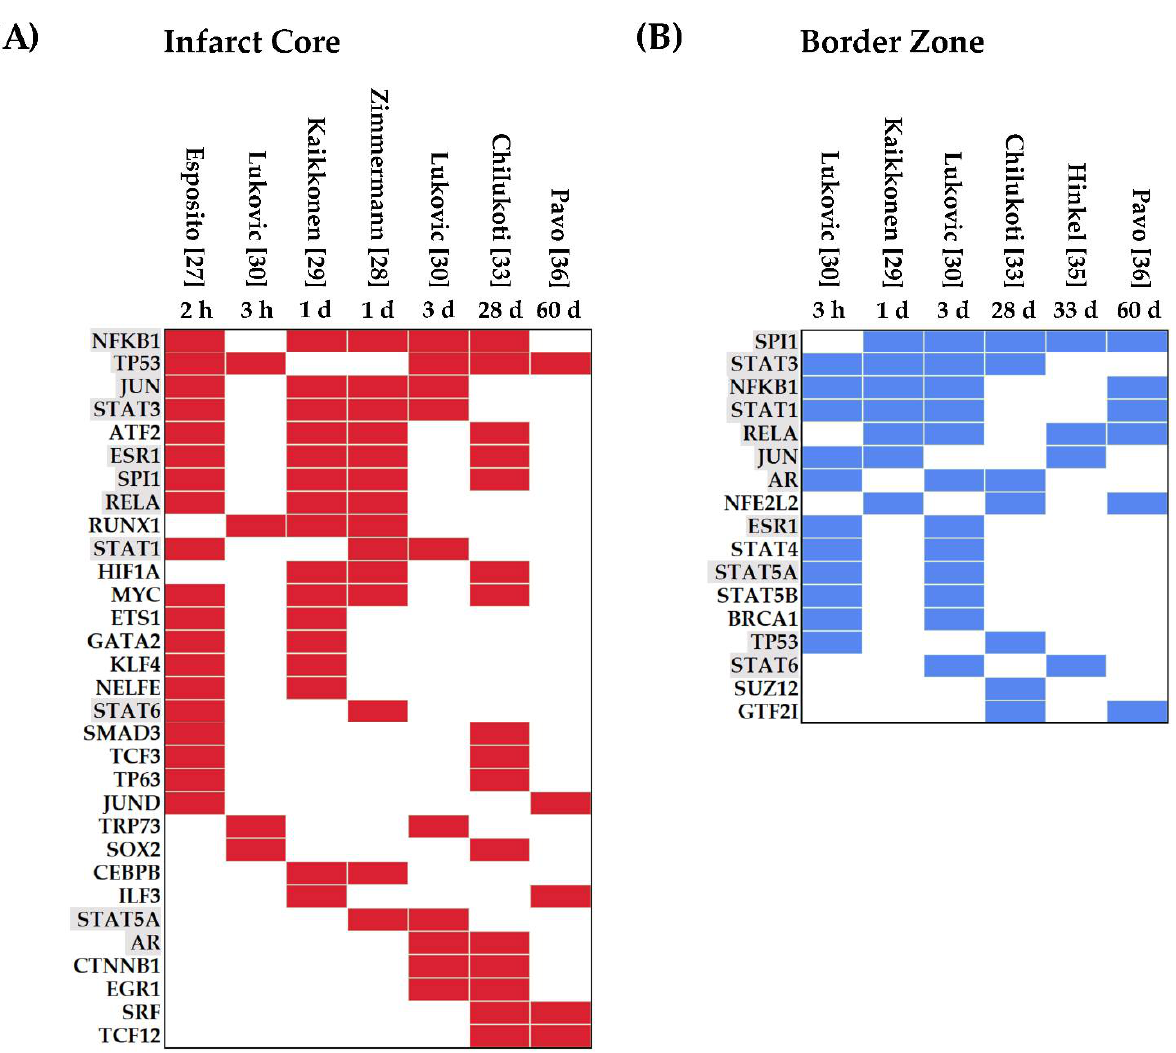
Figure 3. Active Transcription Factors (TFs) in the Infarct Core ( A ) and the Border Zone ( B ). For each histological area, upregulated genes registered in the published data sets were analyzed separately using Enrichr to identify active TFs in each study. Only results with significant adjusted p -values (<0.05) were considered as active in the tissues corresponding to each data set. Identified active TFs in at least two data sets were defined as active in this comprehensive IRI analysis. Active TFs were ordered chronologically. Colored boxes indicate the active TFs. Active TFs common to the Infarct Core and the Border Zone are highlighted in grey. Listed Active TFs from each histological area were compared to identify similarities using a Venn diagram (not shown).